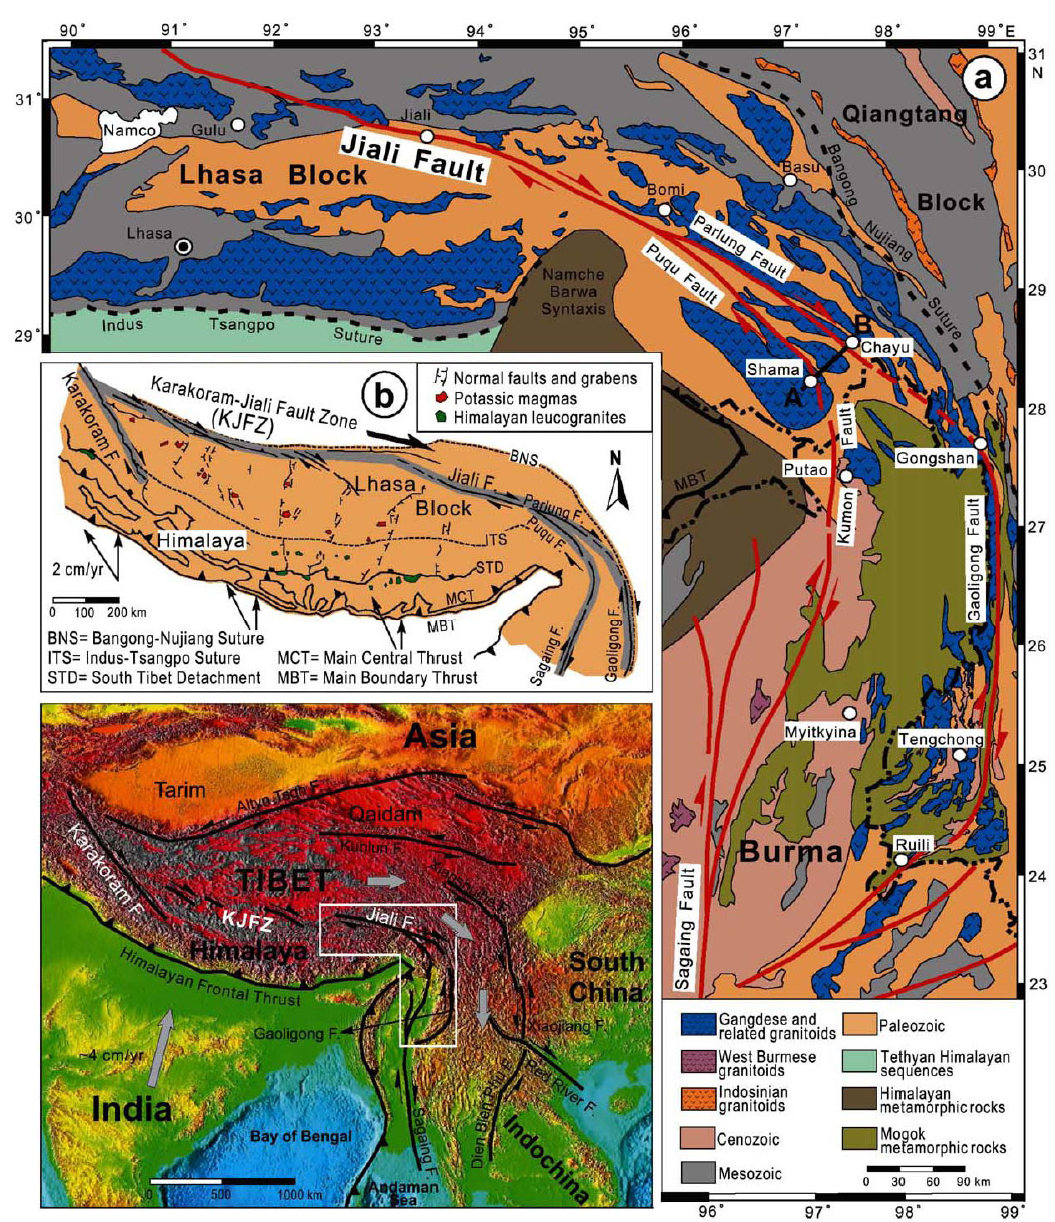
Figure 2. The topography and the principal active faults in Tibet and its adjacent regions. Here white arrows indicate the current movements of India and Northern Tibet and the ongoing clockwise rotation followed by the southward extrusion. ( a ) The simplified geologic map of the study area; ( b ) The tectonic map showing the activities of the Himalayas and Southern Tibet. Reprint with the permission of [36], 2003 copyright